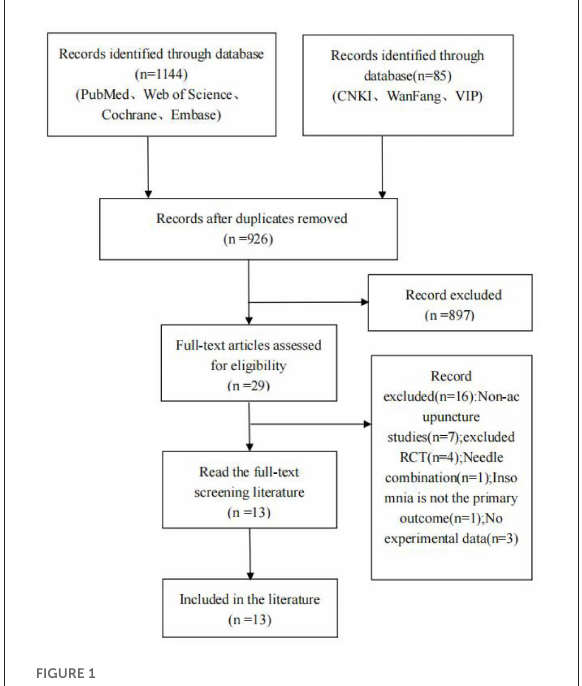
FIGURE1 PRISMA flow diagram of included